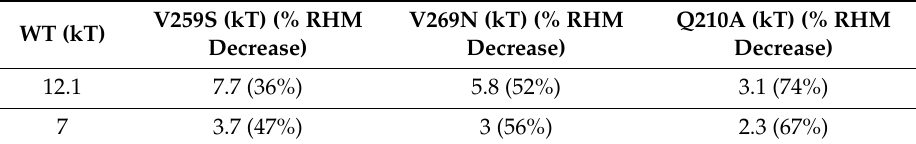
Table 1. Percent change of residual hydrophobic mismatch for channelrhodopsin-2 when compared to wild type protein, calculated with respect to the RHM of the entire protein. The average energy cost of RHM for WT channelrhodopsin-2 and select mutant constructs embedded in a POPC bilayer was calculated for the entire ChR2 homology model across the bilayer (top row) and leaving out TM1 residues modeled as being in a loop (bottom row). The relative rank of differences among the constructs is unchanged under the two conditions. These differences in RHM among constructs are consistent with the pattern of experimentally observed differences in the function of the constructs.